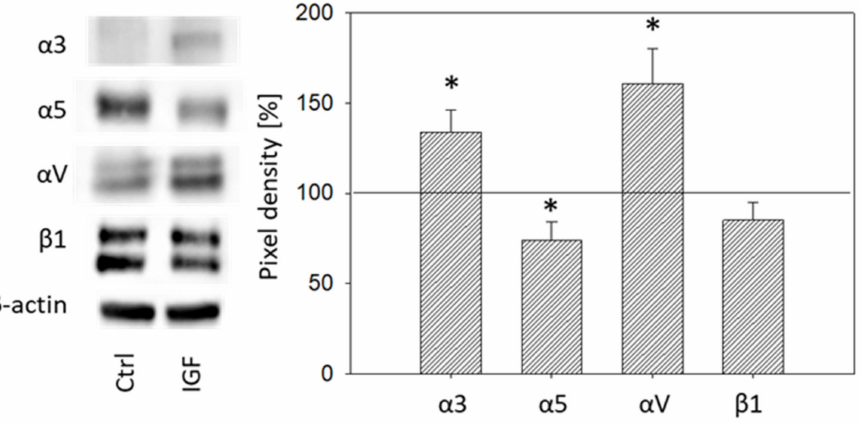
Figure 8. Left side: Protein profile of integrins α 3, α 5, α V, and β 1. DU145 cells were either stimulated with IGF-1 for 24 h or exposed to culture medium without IGF-1 (Ctrl). One representative of three separate experiments is shown. Each protein analysis was accompanied by a β -actin loading control. One representative internal control is shown. Right side: Pixel density analysis of the protein expression level of DU145 cells stimulated with IGF. The ratio of protein intensity/ β -actin intensity is expressed as percentage of controls, indicated by line at 100%. * indicates significant difference to